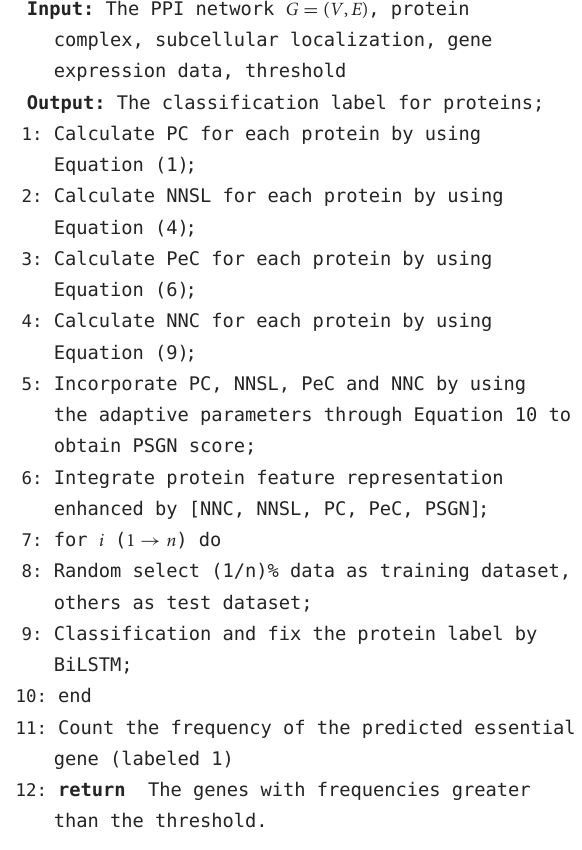
ranked proteins as the essential protein candidates (like top 100), after that the accuracy of identification could be computed by counting the number of true essential